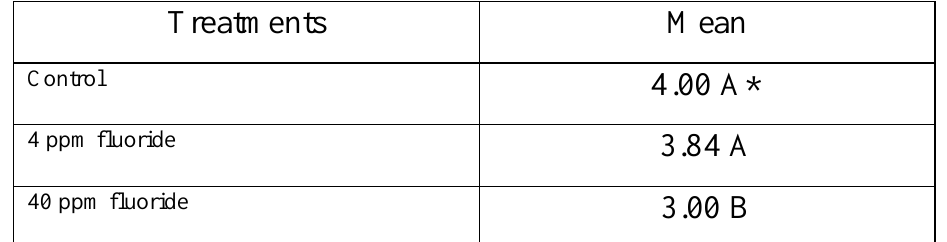
Table (3): Effect of fluoride on body / texture scores of Cheddar cheese on both days 60 and 120 of